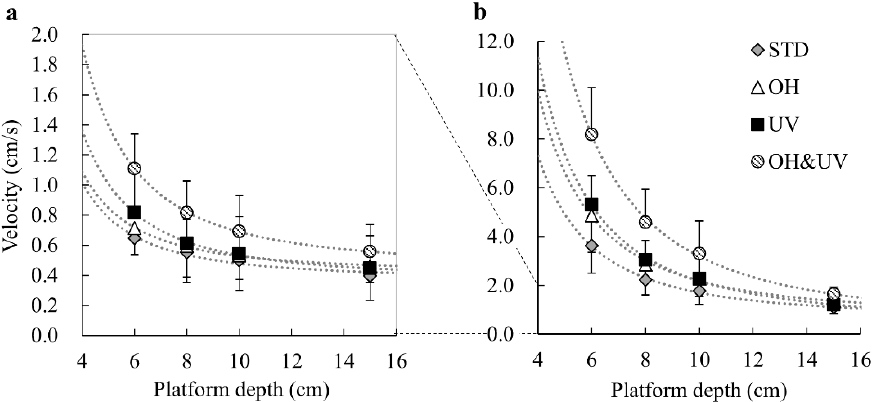
Figure 6. Translational velocity of the ( a ) center of mass and ( b ) center of pressure. Dotted lines show the approximate curves for the negative square of the platform depth ( y = a / d 2 + b ). For coefficients of the fitting functions and the significance test of the regression model, see Appendix A.